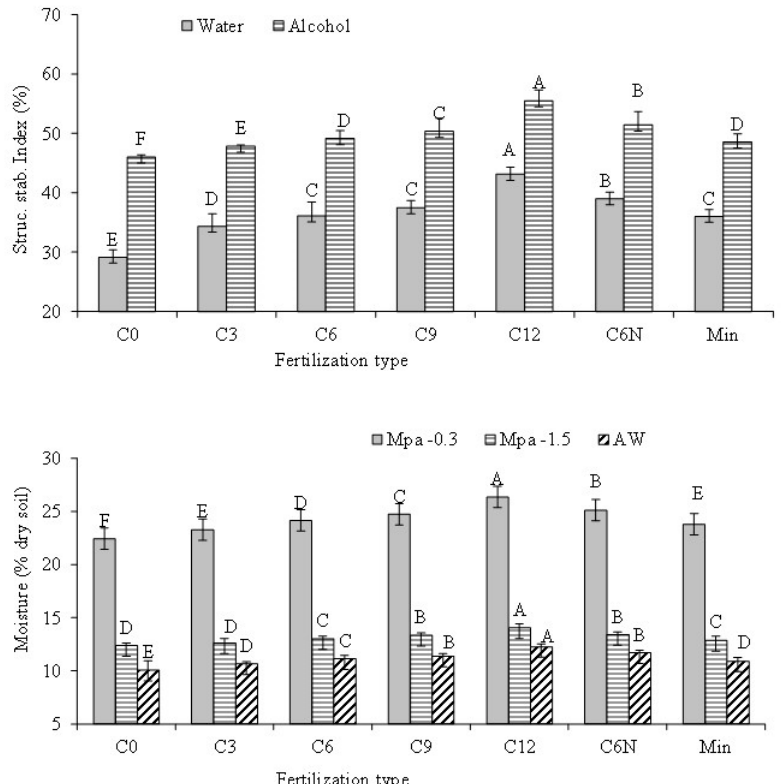
Figure 2. Structure stability and hydrologic properties of the potting soils amended for three-years with increasing doses of sewage sludge compost and supplied by mineral fertilization. Mpa: Mega Pascal; AW: available water. C0, unfertilized soil; C3, C6, C9 and C12 = 3, 6, 9 and 12 Mg/ha sewage sludge compost, respectively; C6N, combined application of 6 Mg/ha of sewage sludge and 60 kg/ha N; Min, mineral fertilization. The values with the same letter are not significantly different, according to the SNK test at p ≤ 0.01. Vertical bars represent the standard errors of means.